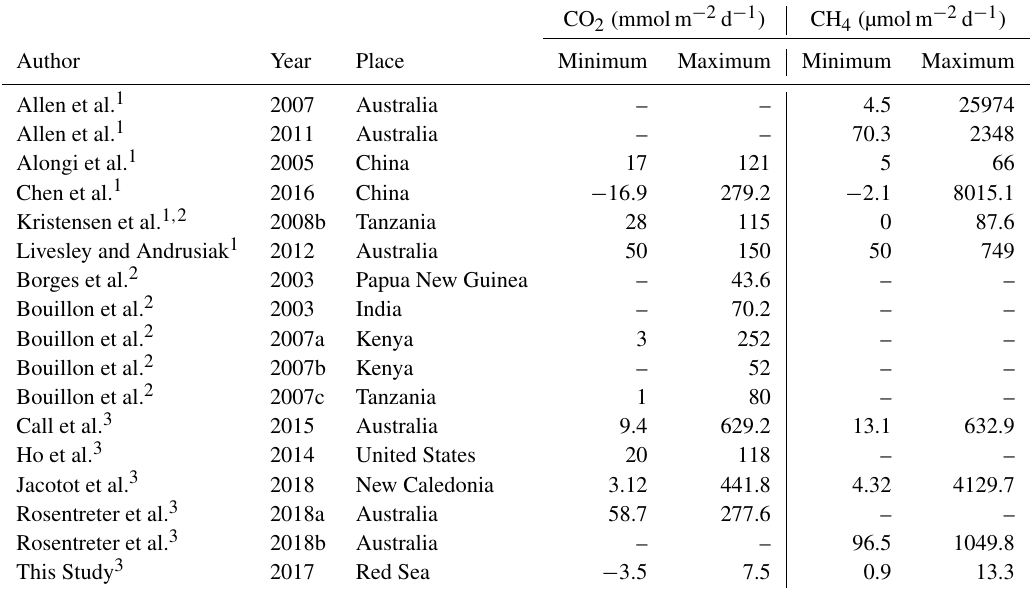
Table 2. Comparison of GHG fluxes from global mangrove forests and Red Sea mangroves. Literature values converted from reported form for comparison purposes. Measurements made at the 1 soil–atmosphere interface, 2 air–sea interface with DIC calculation methods, and 3 air–sea interface with equilibration